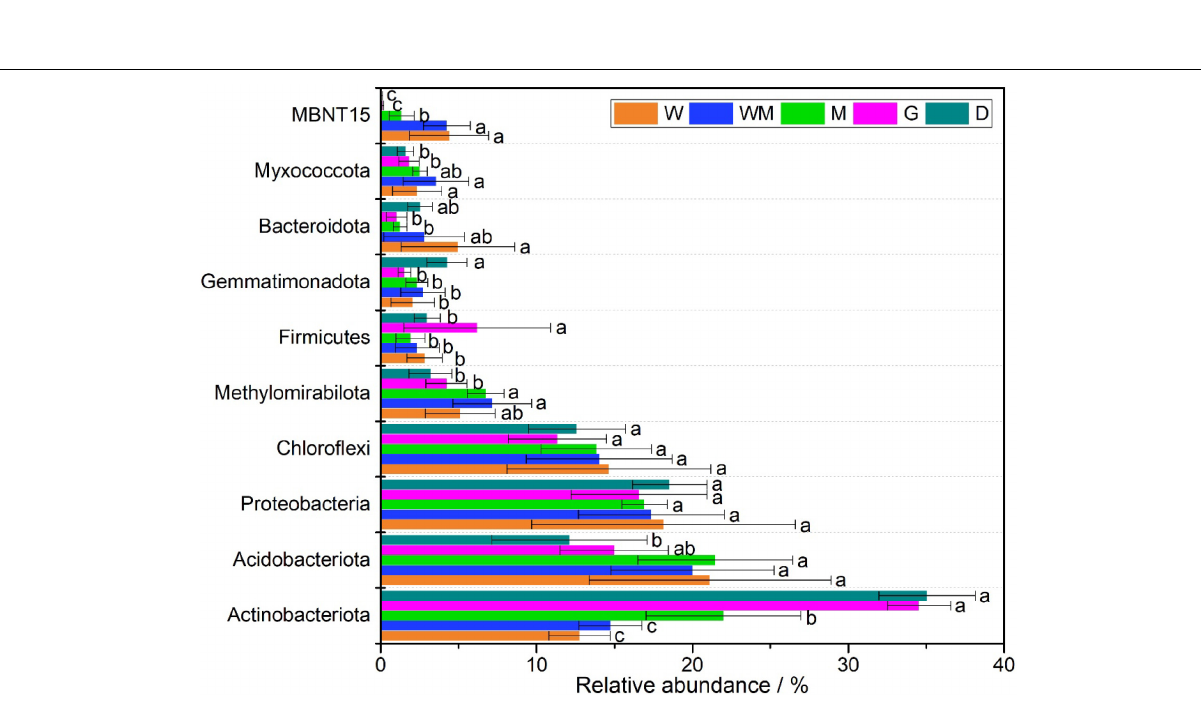
Frontiers in Microbiology |